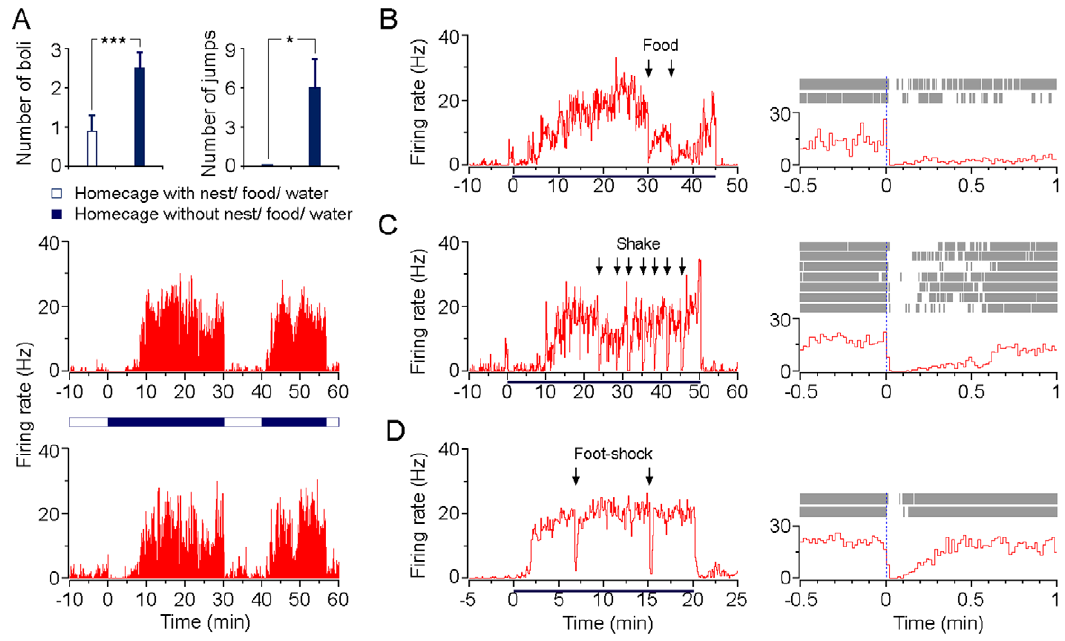
Figure 4. Responsiveness of type-1 BLA neurons to environmental changes. (A) Upper panels, anxiety-like behaviors were significantly elicited when nest/food/water cup were removed from homecage (n=10; mean 6 SEM). * P , 0.05, *** P , 0.001 by t -test. Lower panels, rate histograms of two simultaneously recorded type-1 BLA neurons in response to the removal (twice; at 0:00 & 40:00, respectively) and return (twice; at 30:00 & 56:30, respectively) of the nest/food/water cup in the homecage. (B-D) Left panels, rate histograms of type-1 BLA neurons in response to open-field-like environmental exposures and external stimuli deliveries. Horizontal lines below each histogram indicate the exposure durations. Arrows indicate the time onset of food delivery (B), shake stimuli (C) and foot-shocks (D). Right panels, perievent raster plots and the perievent histograms referenced to each external stimulus on the left, respectively.